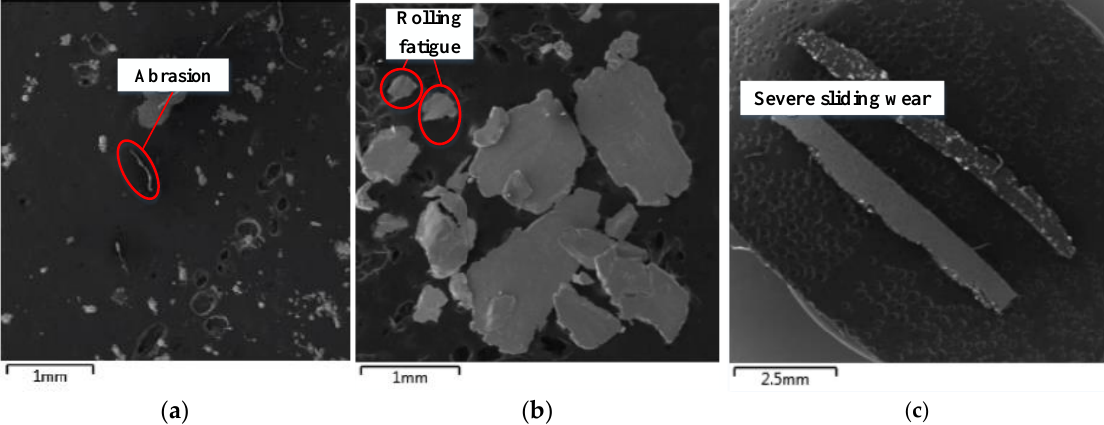
Figure 8. Electronic image of wear particles under actual working conditions. ( a ) Abrasion; ( b ) Rolling fatigue; ( c ) Severe sliding wear.